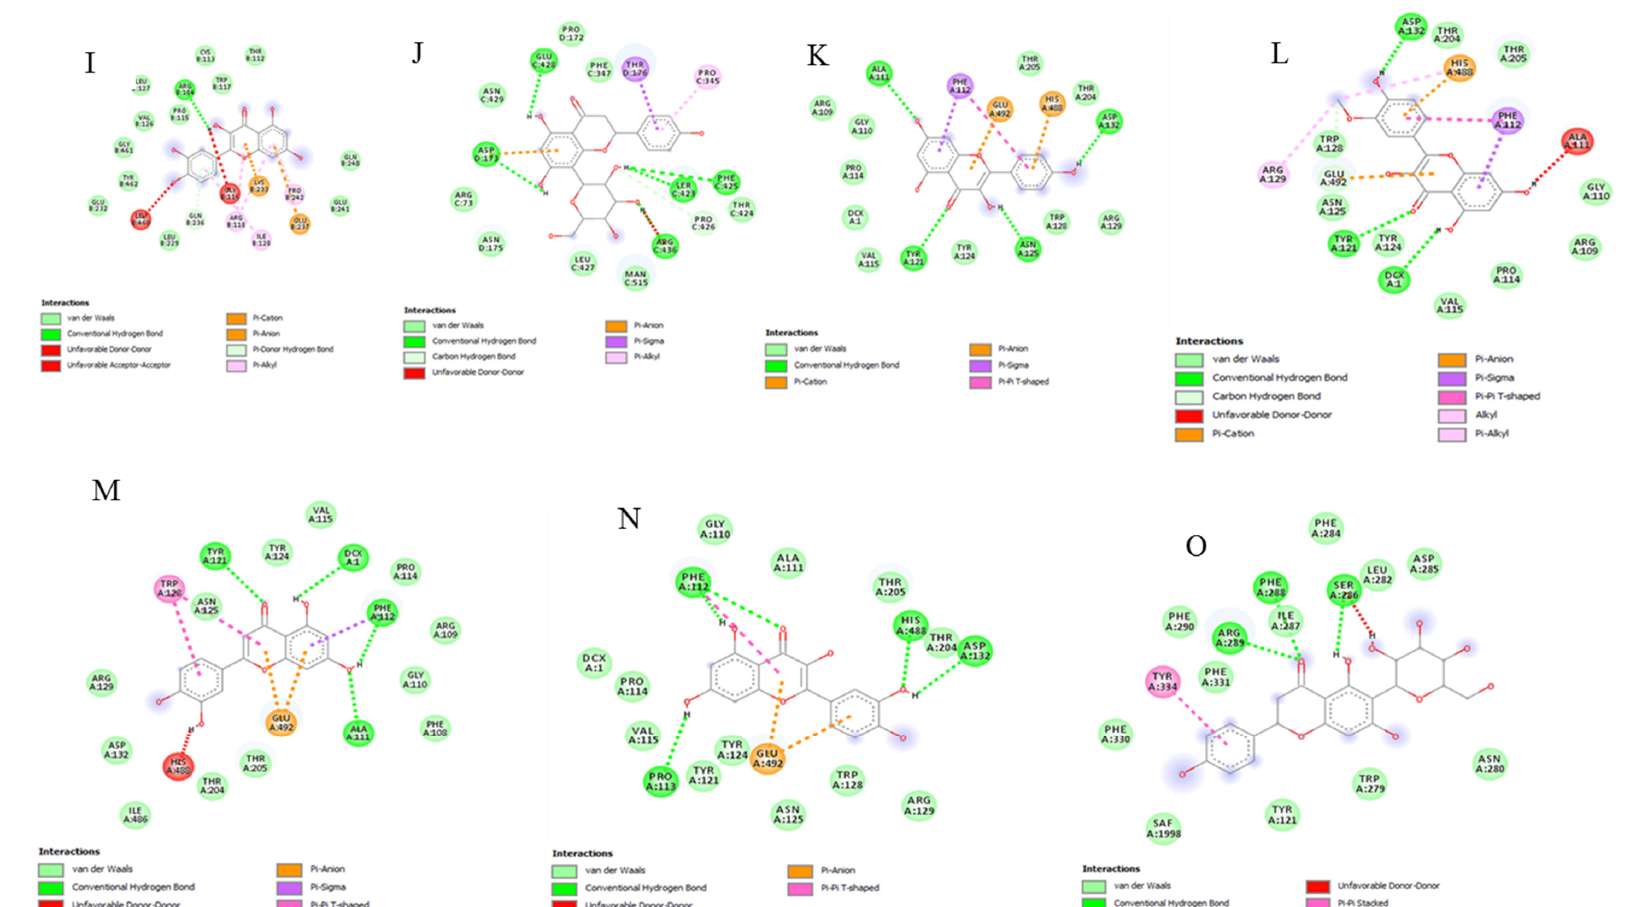
Figure 2. ( A ): Putative interaction between apigenin and COX-2 (PDB: 1CX2). Free energy of binding ( ∆ G) and a ffi nity (Ki) are − 8.8 kcal / mol and 0.4 µ M, respectively; ( B ): Putative interaction between chrysoeriol and COX-2 (PDB: 1CX2). Free energy of binding ( ∆ G) and a ffi nity (Ki) are − 9.3 kcal / mol and 0.2 µ M, respectively; ( C ): Putative interaction between luteolin and COX-2 (PDB: 1CX2). Free energy of binding ( ∆ G) and a ffi nity (Ki) are − 9.5 kcal / mol and 0.1 µ M, respectively; ( D ): Putative interaction between quercetin and COX-2 (PDB: 1CX2). Free energy of binding ( ∆ G) and a ffi nity (Ki) are − 9.3 kcal / mol and 0.2 µ M, respectively; ( E ): Putative interaction between loliolide and COX-2 (PDB: 1CX2). Free energy of binding ( ∆ G) and a ffi nity (Ki) are − 6.8 kcal / mol and 10.5 µ M,